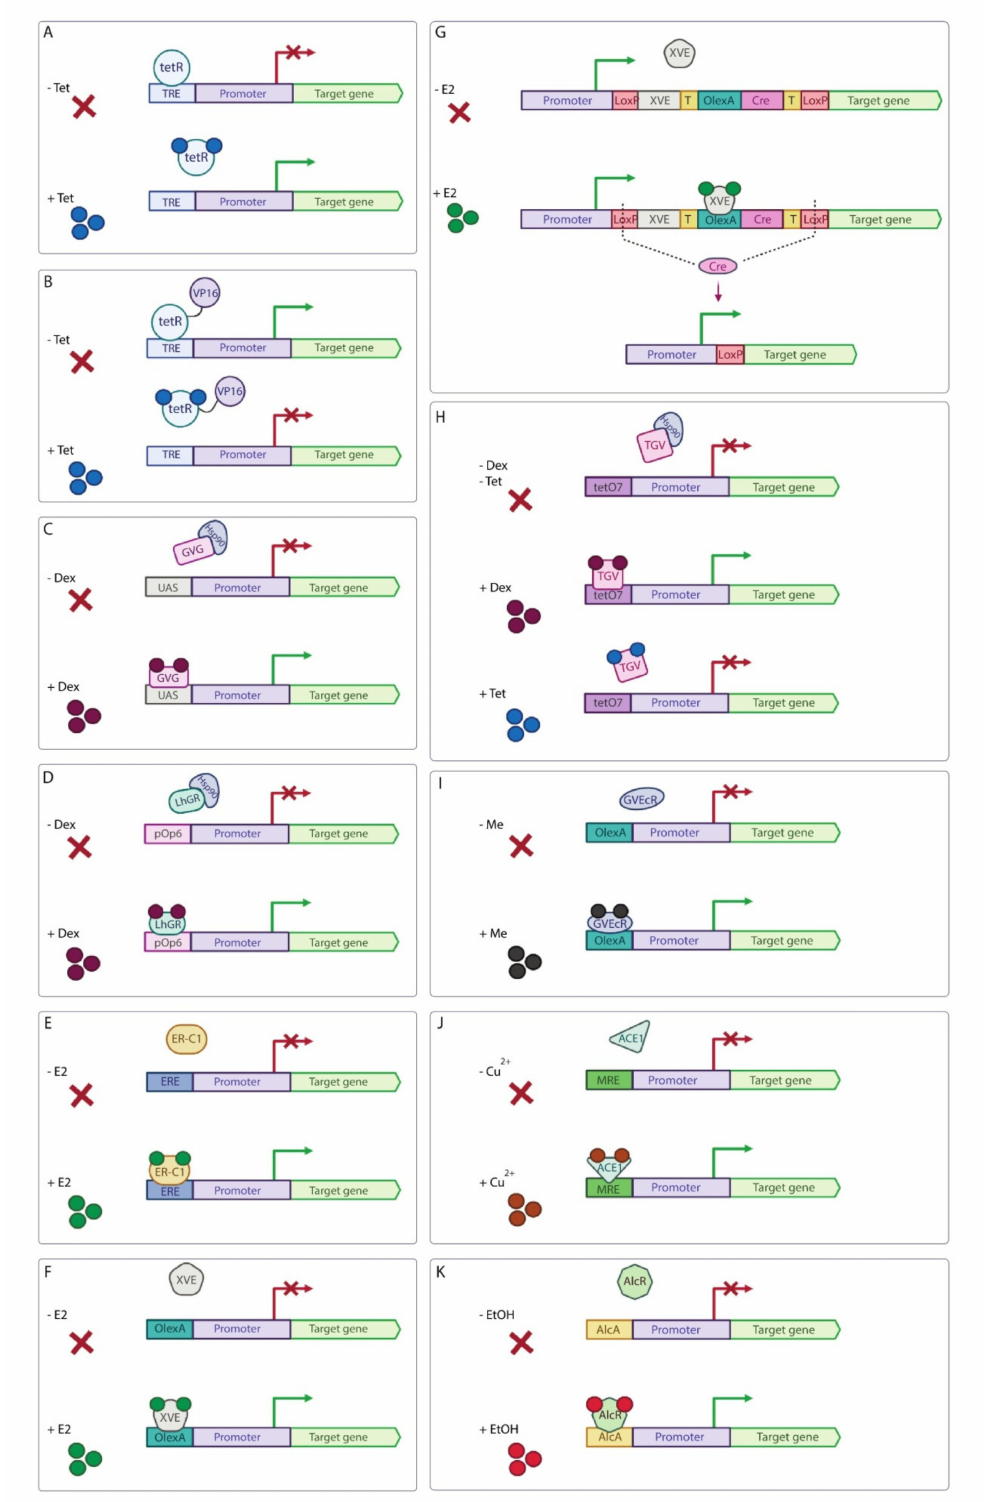
Figure 6. Schematic representation of chemically-inducible systems for regulation of transgene expression in plants. ( A ) The Tet-derepressible system. In the absence of tetracycline (Tet), tetR